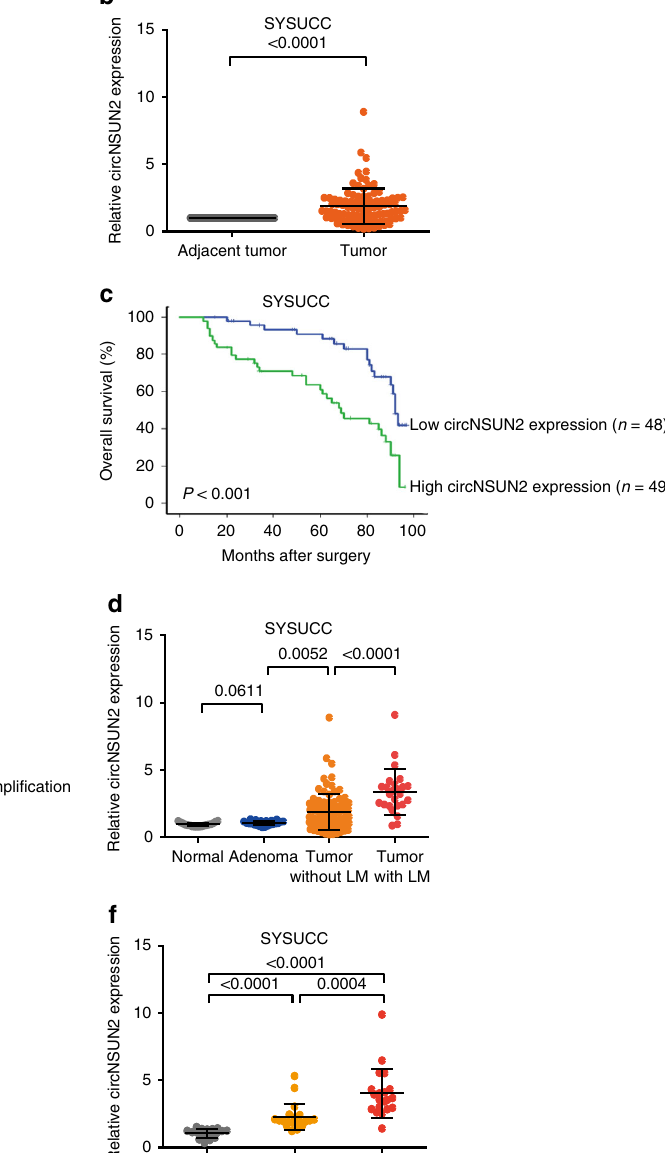
HCT116 cells according to previously described methodol- ogy 18,33 . After examined by RT-PCR with divergent primers, the sequenced PCR product was corresponded to the 5 ′ exon 5 to 3 ′ exon 4 (Fig. 2a). Resistance to digestion with RNase R exonu- clease con fi rmed that this RNA species harbors a circular RNA structure (Fig. 2b). We then used probes that hybridize with the